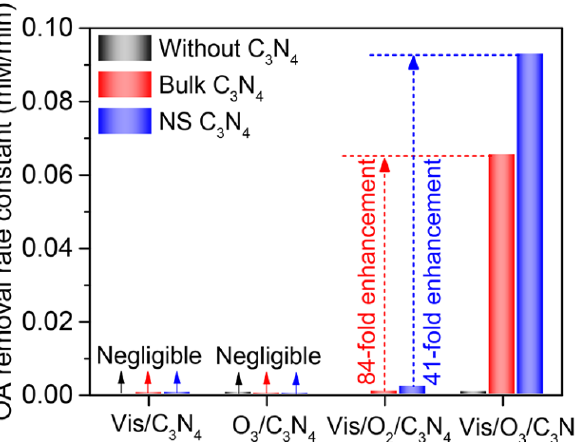
Figure 3. OA degradation rate constants upon irradiation of OA aqueous solutions in the presence of C 3 N 4 under various conditions. Reproduced with permission from ref. [55]. Copyright 2017 American Chemical Society.